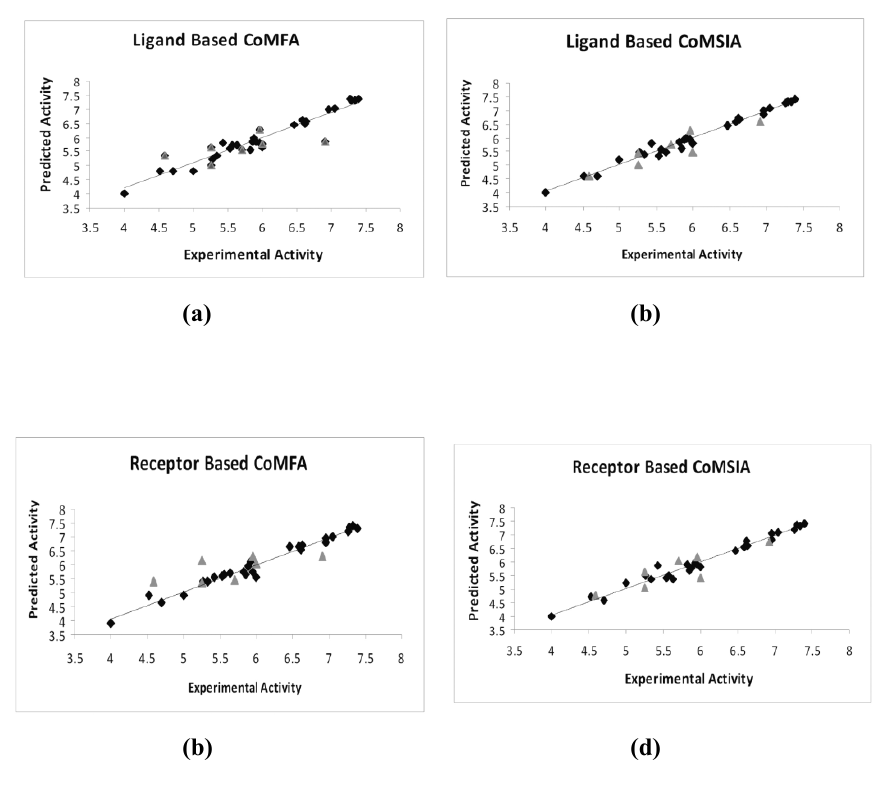
values for the training set (■) and 50